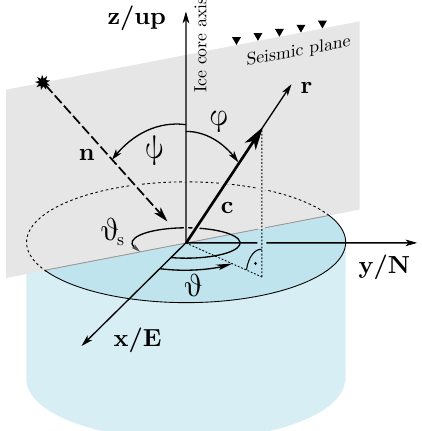
Figure 1. The global coordinate system { x,y,z }, typically corre- sponding to east, north and up, used for the description of a c axis with the unit length. Spherical coordinates ϑ and ϕ specify the ori- entation of the c axis. For each grain the c axis can be expressed in its local cartesian coordinate system { p, q, r } by (0, 0, 1); p , q are not shown here. The equatorial plane corresponds to the hori- zontal thin section plane. The z axis is assumed to be parallel to the ice-core axis. The orientation of a hypothetical seismic plane (grey) is defined by the seismic azimuth angle ϑ s , with the angle ψ of an incident seismic wave (dashed line) with unit vector normal to the plane wavefront n . The star symbolises the seismic source and the triangles represent a line of seismic